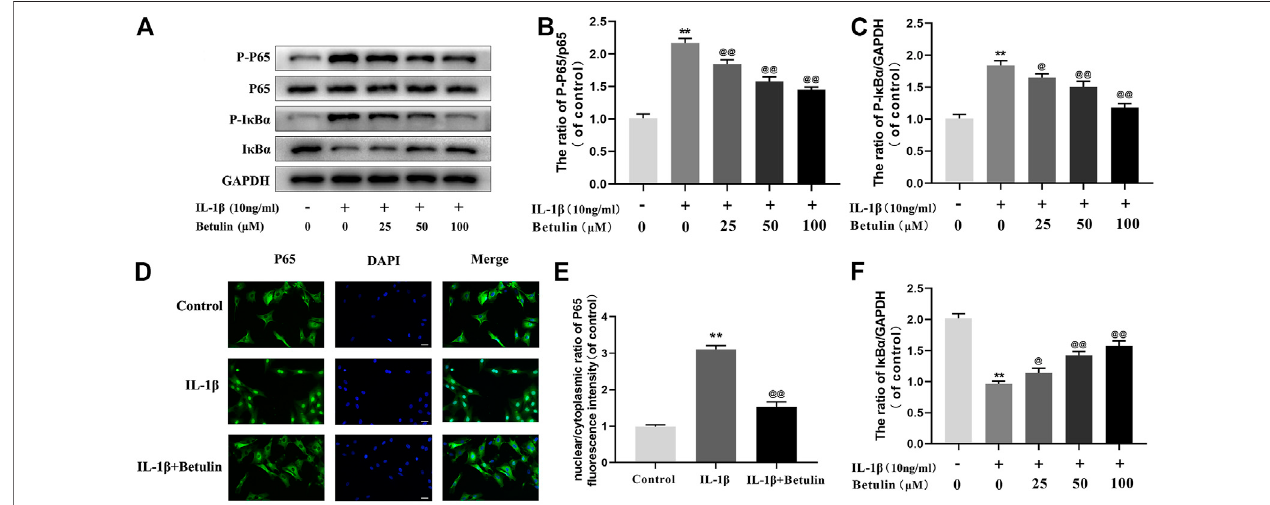
FIGURE 4 | Betulin treatment inhibited the activation of NF- κ B signal. OA chondrocytes were cultured with betulin (0, 25, 50, and 100 μ M) of different concentrationsfor2 h,andthenstimulatedbyIL-1 β (10 ng/ml)for24 h. (A – C , F )Theproteinexpressionlevelsofp-p65,p65,I κ B α ,andp-I κ B α weredetectedbyWestern blot and quantitatively analyzed. (D , E) Immuno fl uorescence staining combined with DAPI staining (scale: 25 μ m) were used to detect the entry of characteristic index p65 into the nucleus and quantitative analysis of fl uorescence intensity. The data in the fi gure are represented as the mean ± SD, ** p < 0.01 compared with the control group, @@ p < 0.01 compared with the IL-1 β group, n (cid:2)